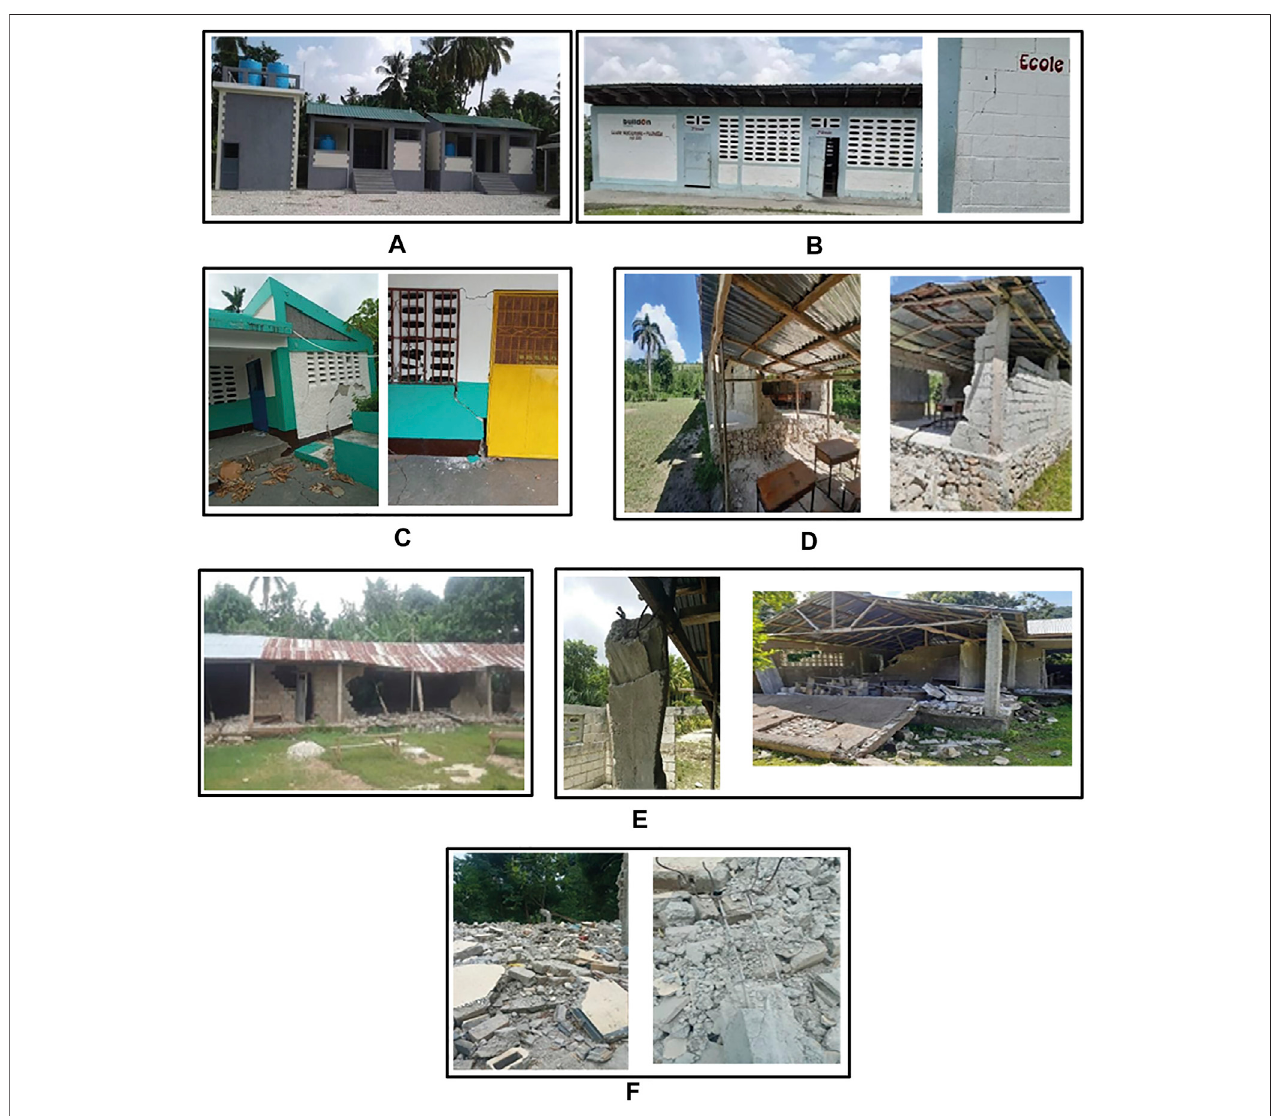
FIGURE13| Examplesofthedamagegrades (A) nodamage, (B) minordamage, (C) moderatedamage, (D) severedamage, (E) partialcollapse, (F) totalcollapse.